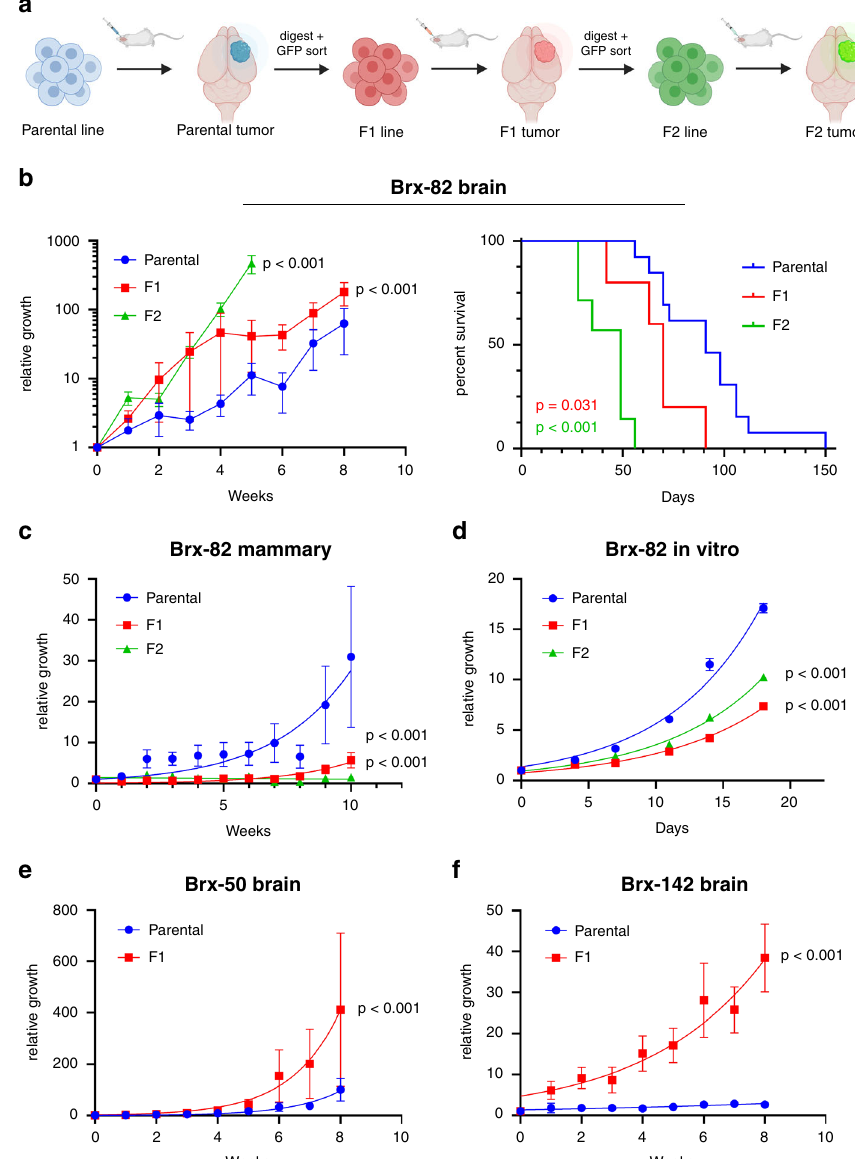
Fig. 2 CTC lines generated from serial injections into the brain exhibit preferential brain growth. a Diagram demonstrating the generation of F1 and F2 CTC lines and tumors. b Left panel: Brain luminescence monitoring of NSG mice following stereotactic brain injection of Brx-82 parental, F1 or F2 cells (parental: n = 7, F1: n = 5, F2: n = 3). P values calculated by the extra sum-of-squares F test. Right panel: Kaplan – Meier analysis of the survival of mice following stereotactic brain injection of Brx-82 parental, F1 or F2 cells (parental: n = 13, F1: n = 5, F2: n = 7). P values calculated by log rank test. P values indicate comparisons of parental and F1 and of parental and F2. c Mammary luminescence monitoring of NSG mice following orthotopic injection of Brx-82 parental, F1 or F2 cells (parental: n = 20, F1: n = 12, F2: n = 14). P values calculated by the extra sum-of-squares F test. P values indicate comparisons of parental and F1 and of parental and F2. d In vitro growth of Brx-82 parental, F1 or F2 cells ( n = 5). P values calculated by the extra sum-of-squares F test. P values indicate comparisons of parental and F1 and of parental and F2. e Brain luminescence monitoring of NSG mice following stereotactic brain injection of Brx-50 parental or F1 cells (parental: n = 10, F1: n = 7). P value calculated by the extra sum-of-squares F test. f Brain luminescence monitoring of NSG mice following stereotactic brain injection of Brx-142 parental or F1 cells (parental: n = 9, F1: n = 6). P value calculated by the extra sum-of-squares F test. Data represent mean ± SEM. Source data are provided as a Source Data fi